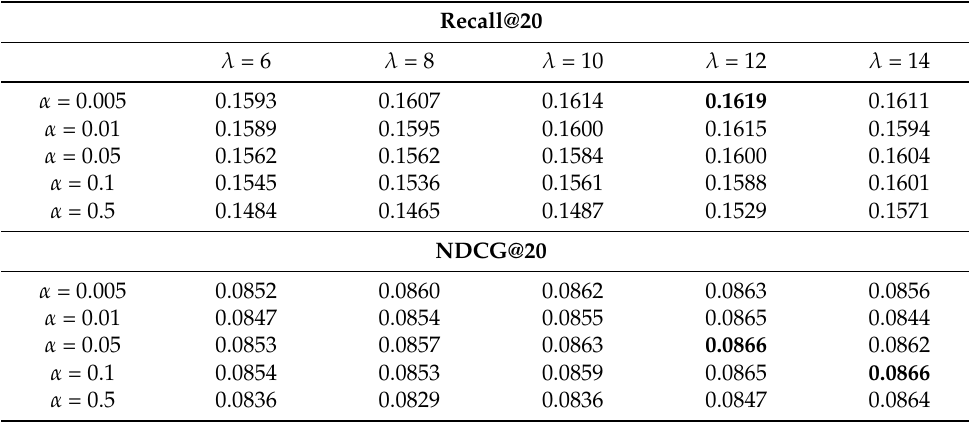
Table 7. Impact of the hyper-parameters α and λ for Amazon-Book.